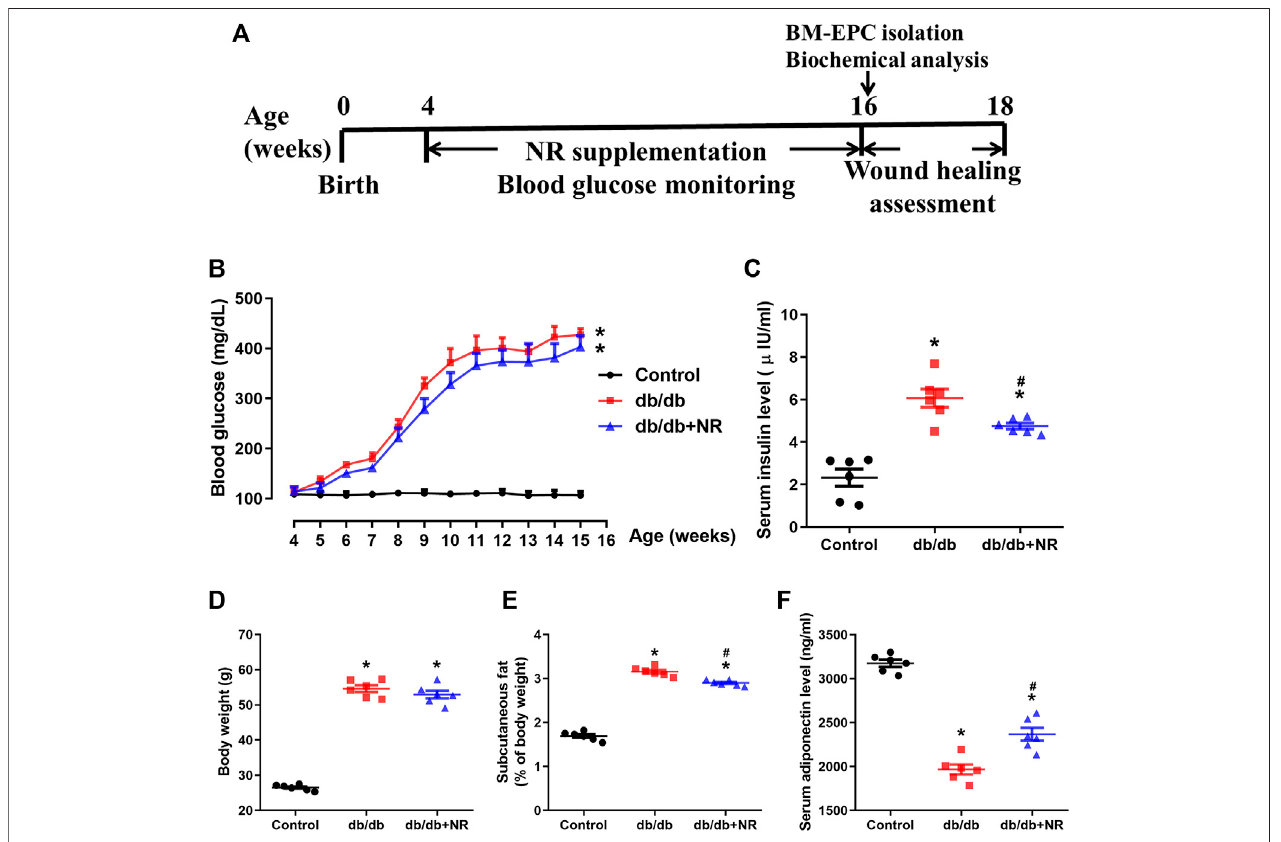
FIGURE1| Effects ofNRsupplement onsomediabetes mellitus – related symptoms. (A) Experimentalschedule. Db/db mice (4 weeksold) werefedwithcommon food or NR-supplied food (400 mg/kg/d) for consecutive 12 weeks, and the blood glucose was monitored every week. After that, each group mice were further divided into 2cohorts: excisional woundexperiment and BM-EPC isolation experiment. Bloodglucose (B) , serum insulin (C) ,body weight (D) ,subcutaneousfat (E) ,and serum adiponectin (F) ofthemicetreatedwithcommonfoodorNR-suppliedfoodfor12 weeks.Valuesaremean ± SEM,( n (cid:2) 6).* P < 0.05 vs. control; # P < 0.05 vs.db/db . BM-EPC, bone marrow – derived endothelial precursor